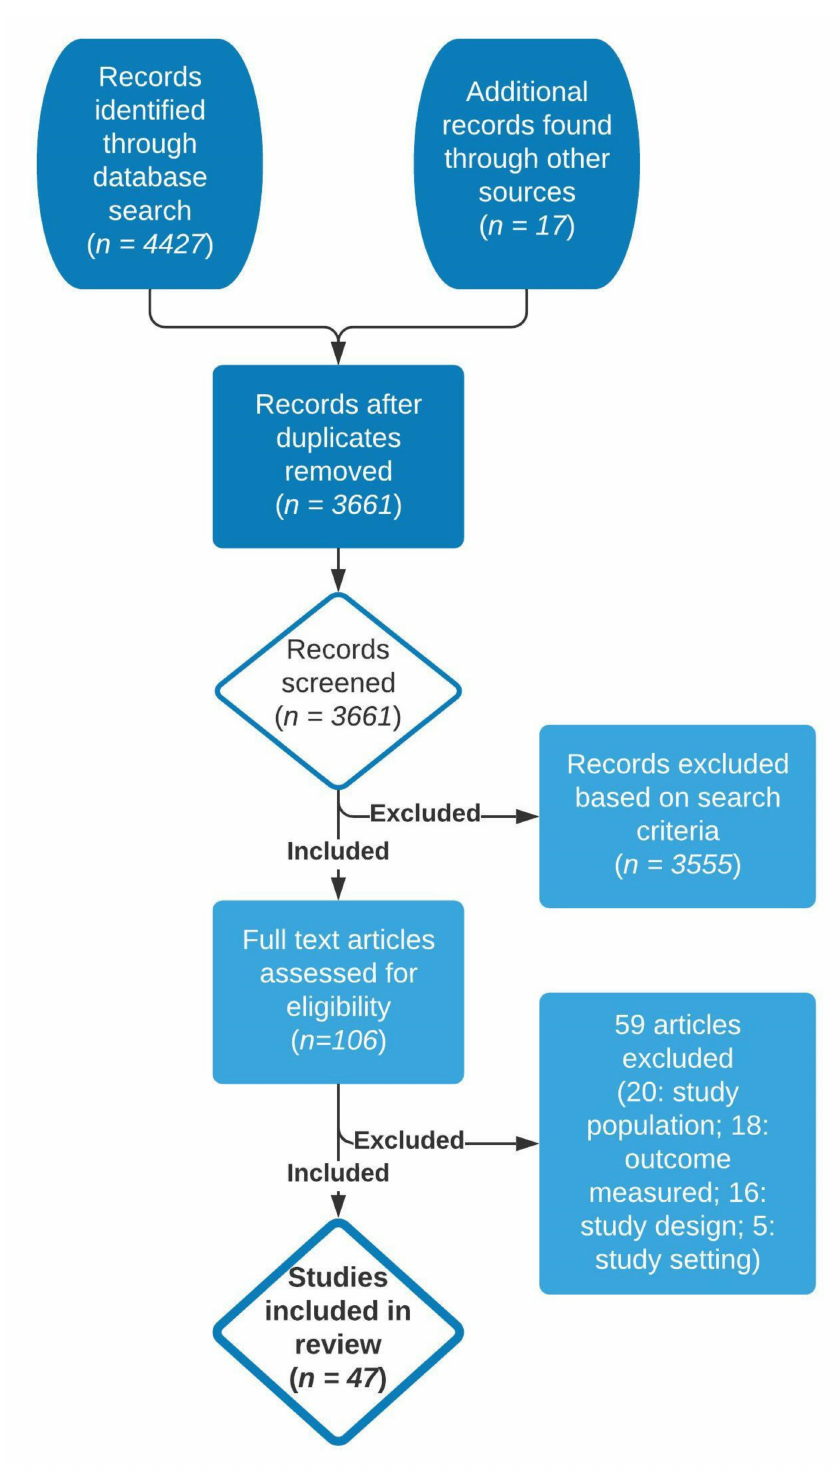
Figure 1. PRISMA flowchart of systematic review process and article screening